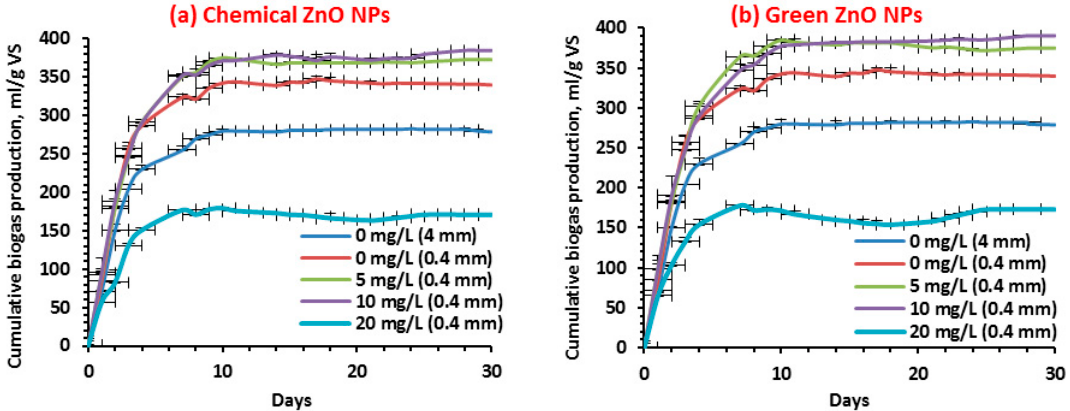
Figure 12. The mean cumulative net biogas production using ( a ) chemical and ( b ) green synthesized ZnO NPs.